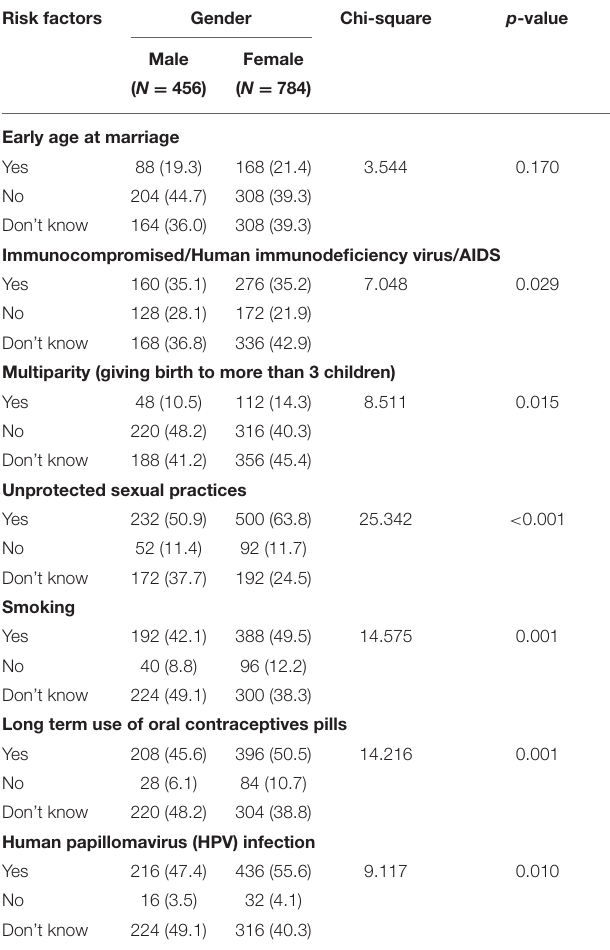
TABLE 4 | Knowledge on cervical cancer risk factors answered by only participants who have heard of cervical cancer. Risk